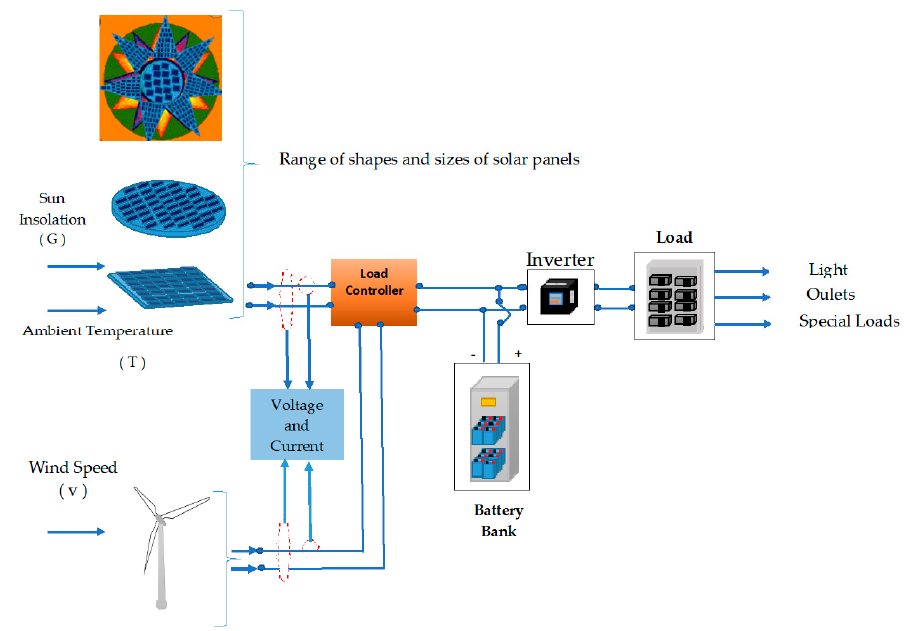
Figure 4. A block diagram with the structure of a hybrid Photovoltaic -wind micro grid system.